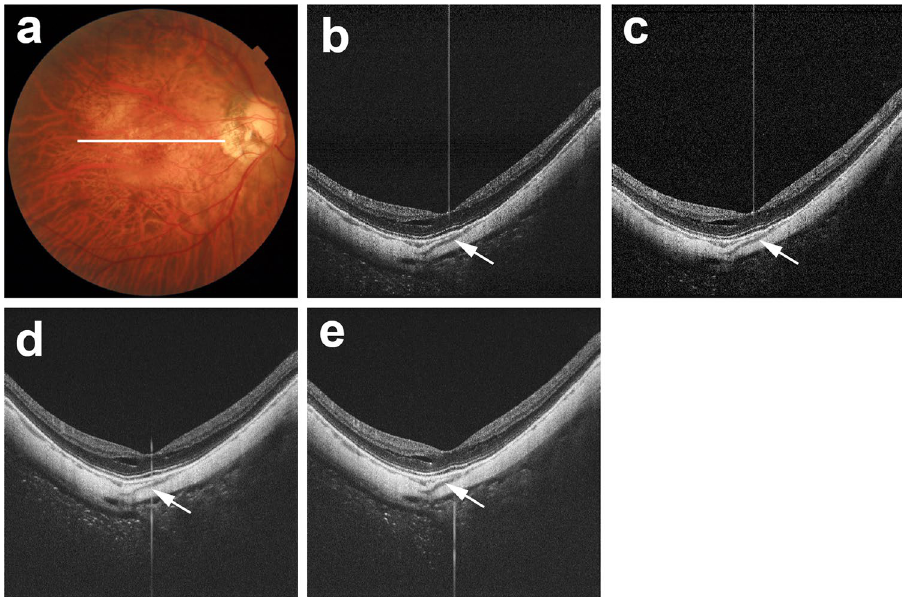
Figure 2. Real scleral vessels without artifactual structures in PD-OCT images and commercial OCT images. The right eye of a 56-year-old woman with pathologic myopia is shown. White line in color fundus image ( a ) indicates the scan line for PD-OCT images and commercial OCT B-scan images ( b – e ). ( b ) Polarization- independent OCT B-scan image ( b ) shows a real scleral vessel (white arrow). Polarization-dependent OCT B-scan image ( c ) and commercial OCT B-scan images from two repeated measurements ( d , e ) also show real scleral vessels (white arrows) without scleral vessel artifacts. The vertical lines in B-scan images ( b – e ) are artifacts by the reflection from a lens inside the OCT system coming into the images as coherent revival noise.